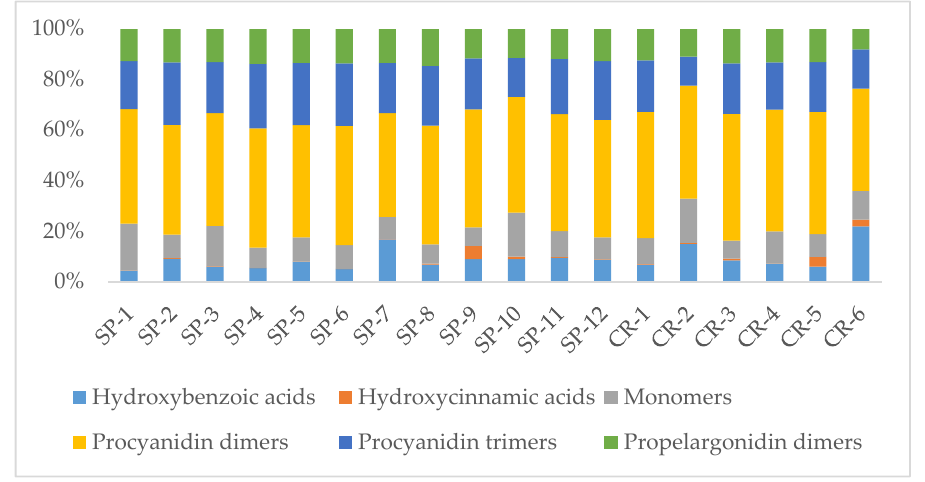
Figure 2. Percentage distribution of polyphenols subclasses by UPLC-DAD/TQ-ESI-MS for U. tomentosa commercial bark extracts. CR—samples acquired in Costa Rica, and SP—samples acquired in